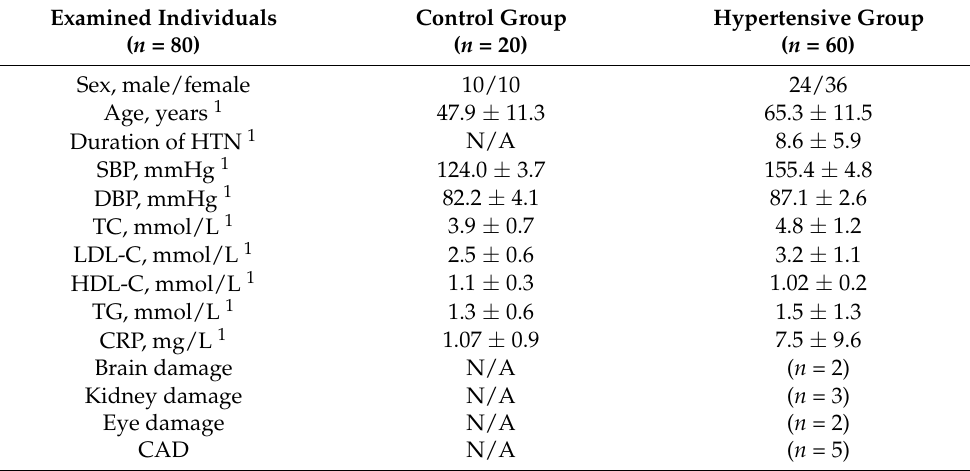
Table 1. Characteristics of the